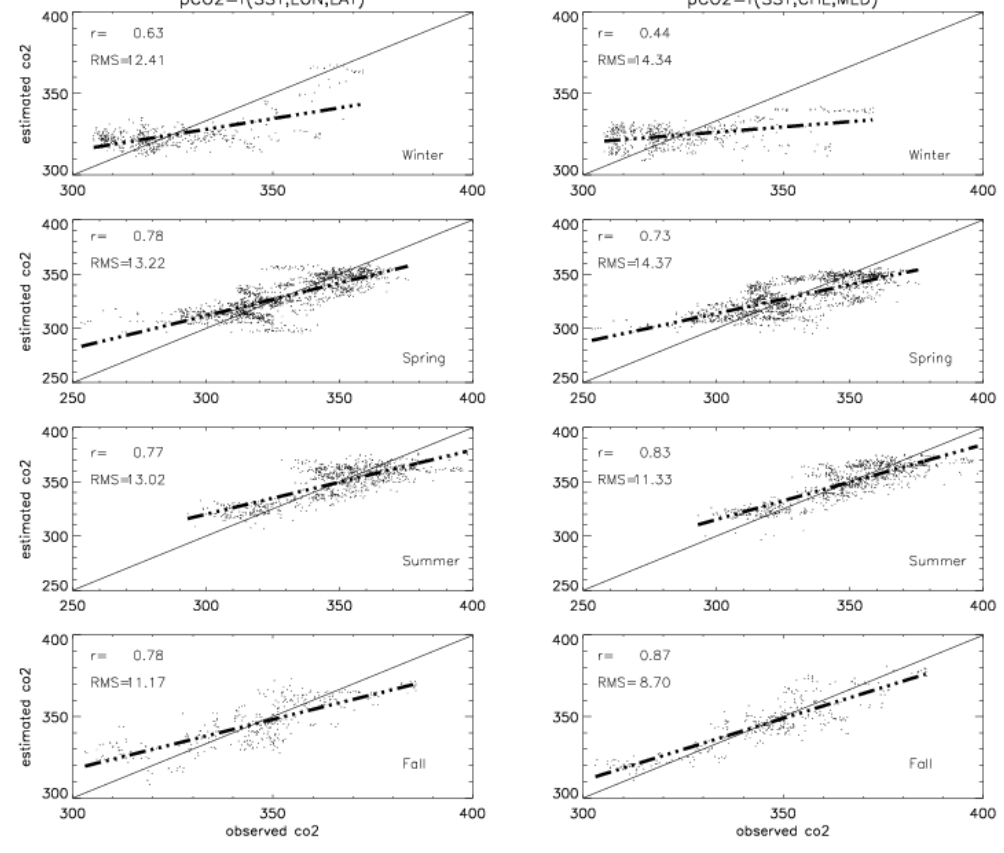
Fig. 4. Scatterplots of the in-situ pCO 2 vs. estimated pCO 2 obtained by the linear regressions defined by Eqs. (3) (right column), (4) (left column) based on the validation data set for winter, spring, summer and